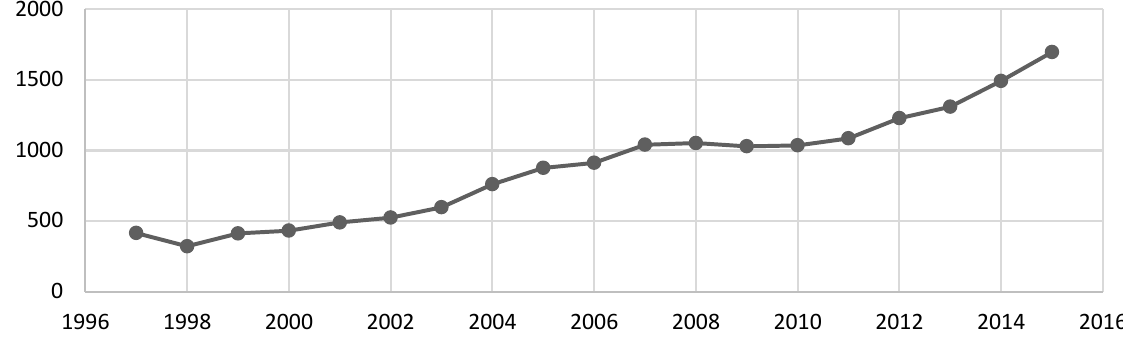
Figure 1. Hits for